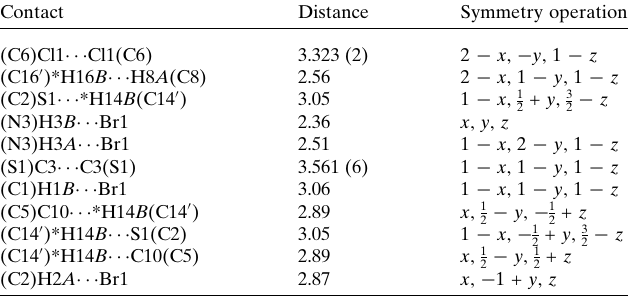
Table 2 Summary of short interatomic contacts (A˚ ) in the title salt. Atoms marked with an asterisk (*) are from the minor component (C11/C12 0 – C16 0 ) of the disordered phenyl ring of the cation. Contact